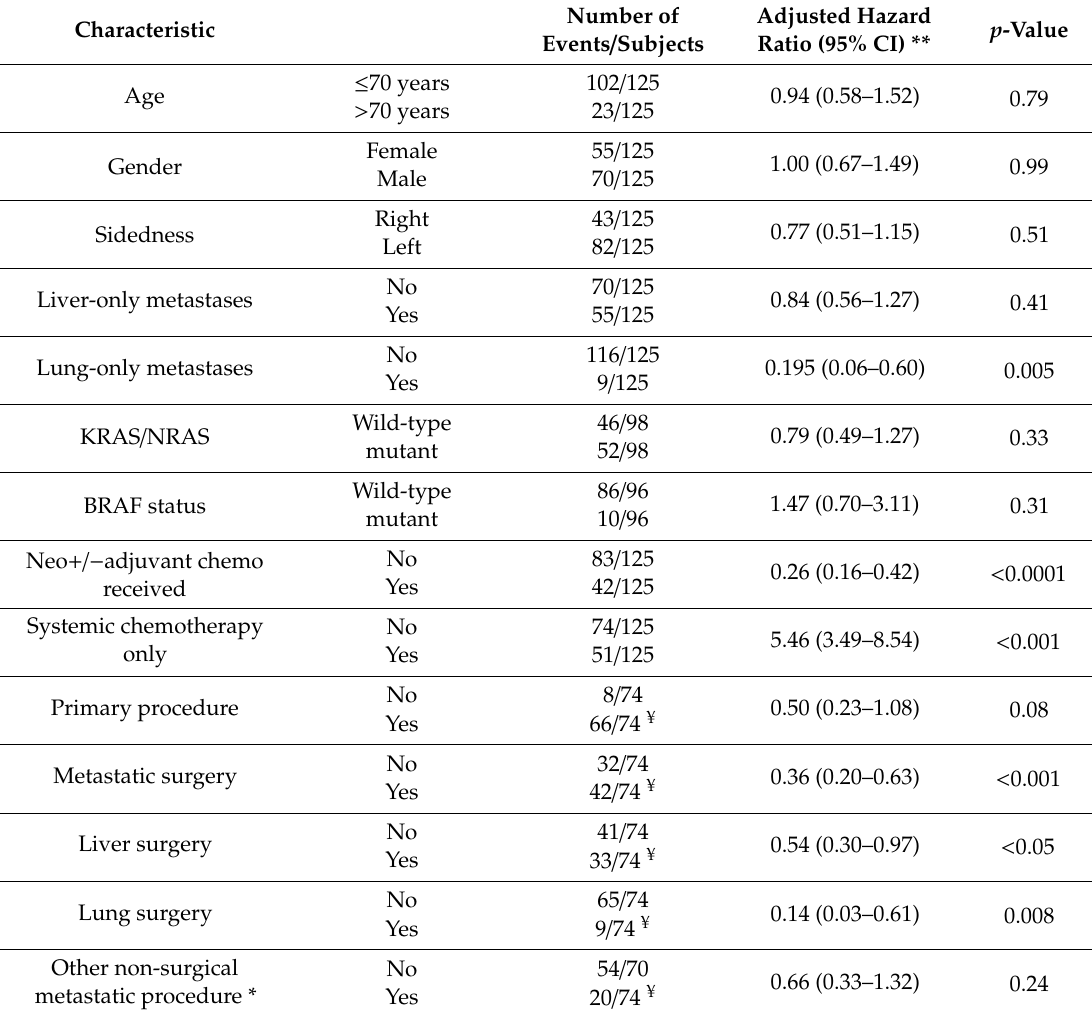
Table 2. Univariate